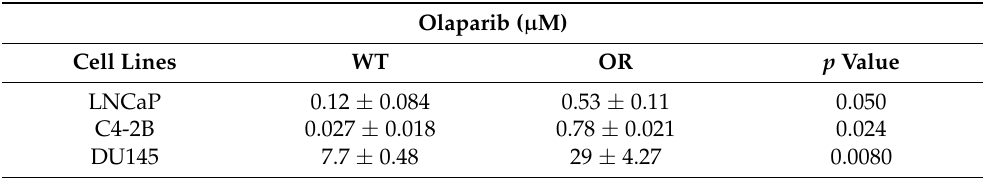
Figure 1. Development of PC cell lines resistant to olaparib (OR) from parental cell lines. ( a ) Schematic representation of PC-OR cell lines development. ( b ) Olaparib IC50 of PC WT and OR cell lines. ( c ) Doubling time of WT and OR cell lines. ( d ) Representative images of WT and OR cell morphology after 4 days of culture. ( e ) PARP1 expression and PARylation activity measured by Western blot on total cell extracts from WT and OR PC cell lines. Actin was used as loading control. For all data, the mean ± SEM of three independent experiments is shown. Data were analyzed using the two-tail Student t -test. n.s. = non-significant. * p < 0.05, ** p < 0.01. Table 2. Comparison of IC50 values for olaparib between PC wild-type (WT) and olaparib-resistant (OR) cell lines.